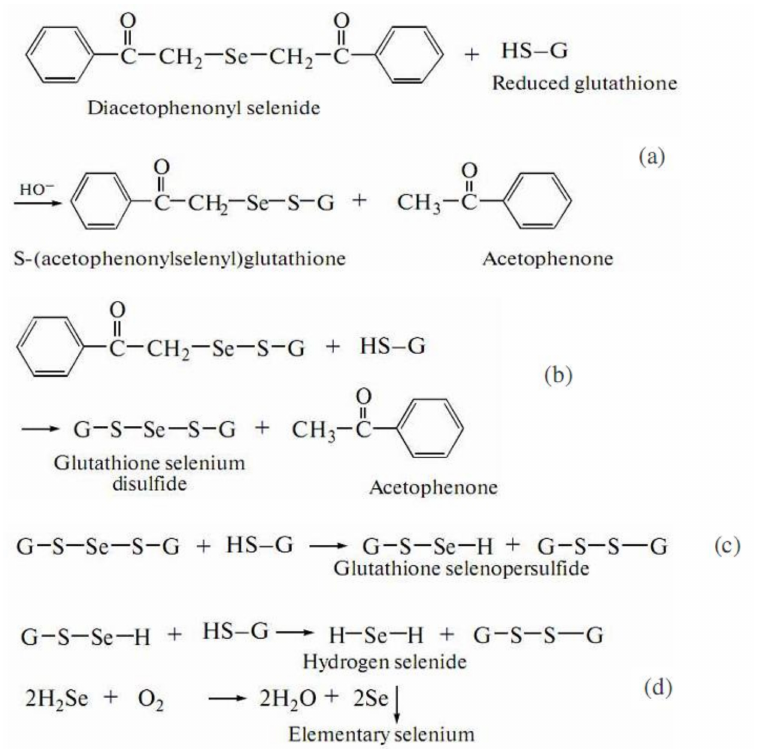
Figure 6. Scheme of DAPS-25 interaction with thiols.